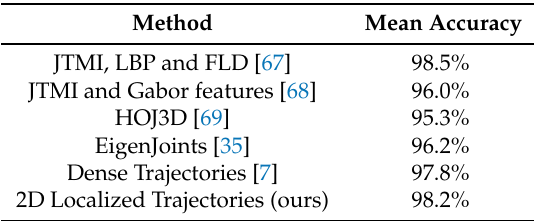
Table 5. Mean accuracy of recognition (%) of Dense Trajectories and 2D Localized Trajectories approaches on KARD